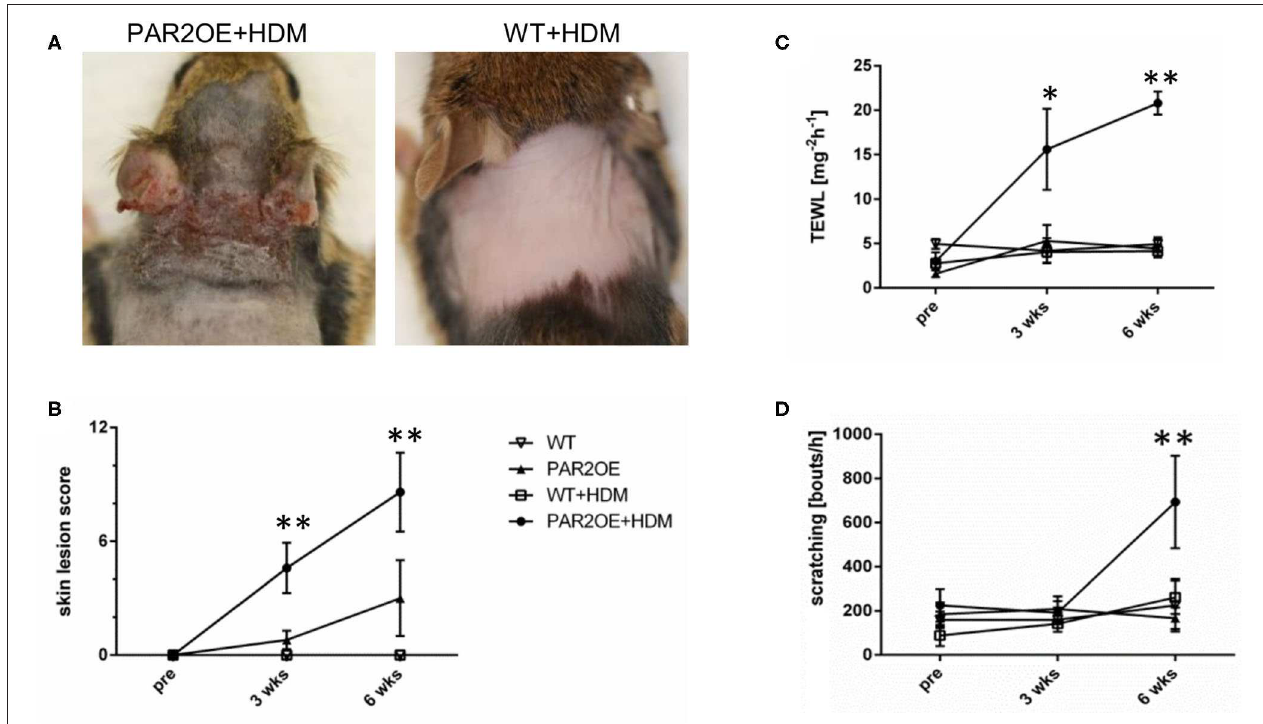
FIGURE 2 | Application of house dust mites triggers eczematous skin lesions and pruritus in PAR2OE mice. (A,B) Skin phenotype by images (partially shaved mice) and skin lesion score of 14-week-old PAR2OE and WT mice, treated with HDM or vehicle for the last 6 weeks ( n = 3–4 mice per group). All graphs in Figure 2 show mean ± SEM. * P < 0.05, ** P < 0.01, (Mann–Whitney U -test). (C,D) As in panel (B) , 14-week-old PAR2OE and WT mice, treated with HDM or vehicle for the last 6 weeks, have been analyzed for transepidermal water loss (TEWL) and their spontaneous scratching behavior during 60min video recording; n = 3–4 mice per group.